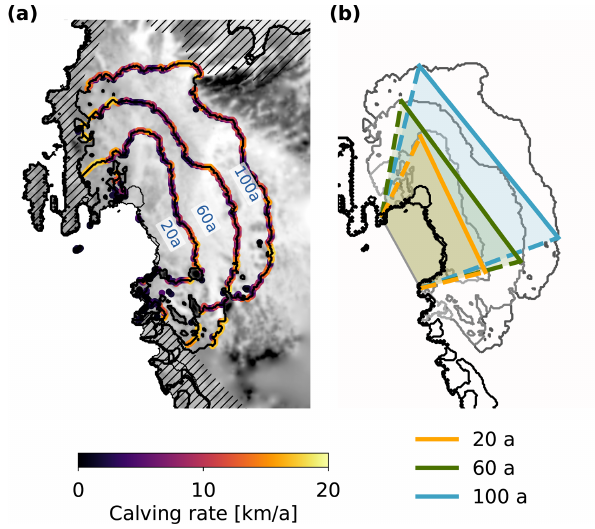
Figure 11. (a) Different grounding-line configurations of the adap- tive cliff-calving experiment CCA100 with unbuttressed calving rates. (b) Idealized embayment geometry derived from the ground- ing